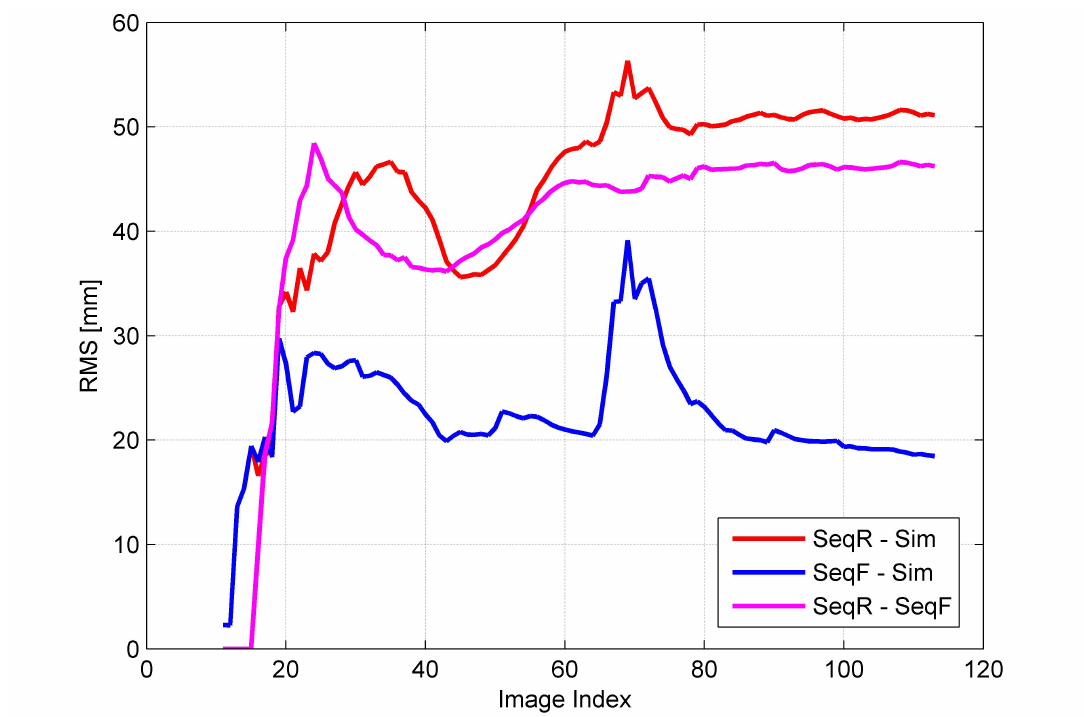
Figure 17. RMS values of GP